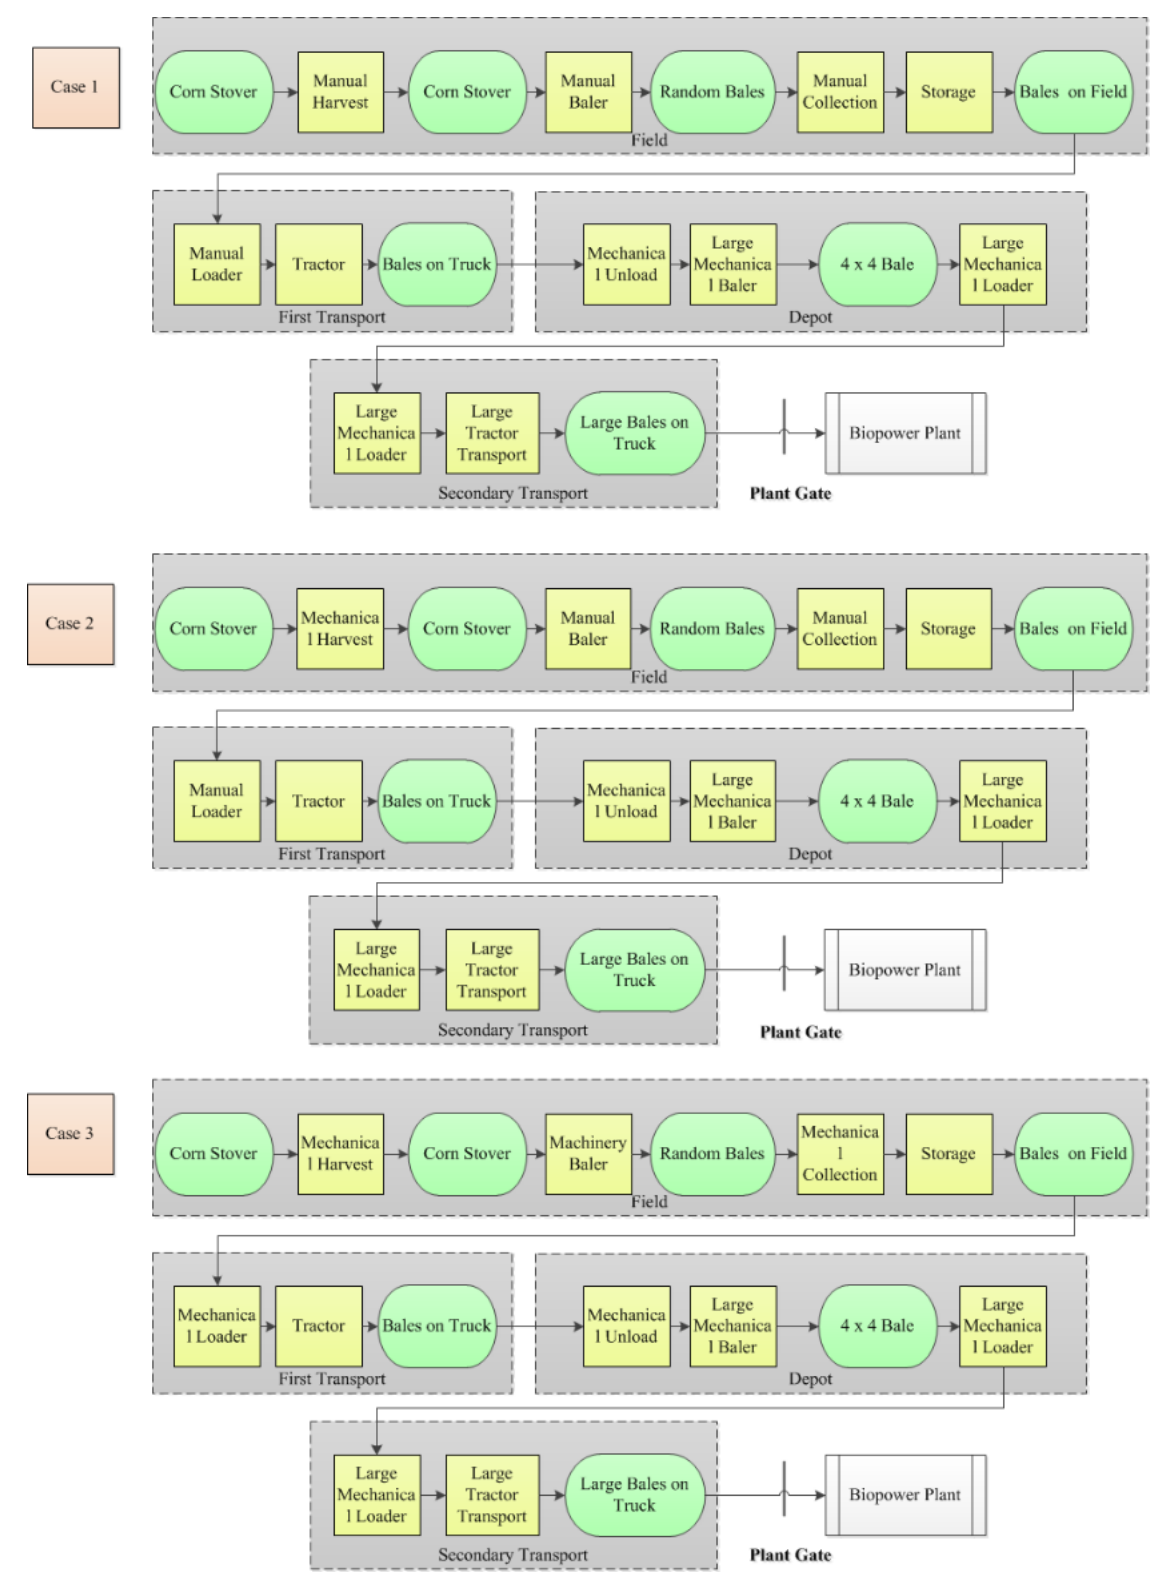
Figure 2. BLM-SinoFS process flow assumptions based on existing corn stover agricultural systems that are common throughout much of rural northeastern China. Cases 1, 2 and 3 describe scenarios at increasing mechanized